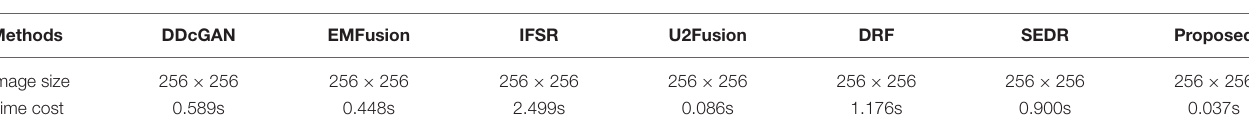
The evaluation is shown as average variance of testing results on 10-group image pairs, which the proposed method adopts for 10-fold verification experiments. ± TABLE 6 | Time cost